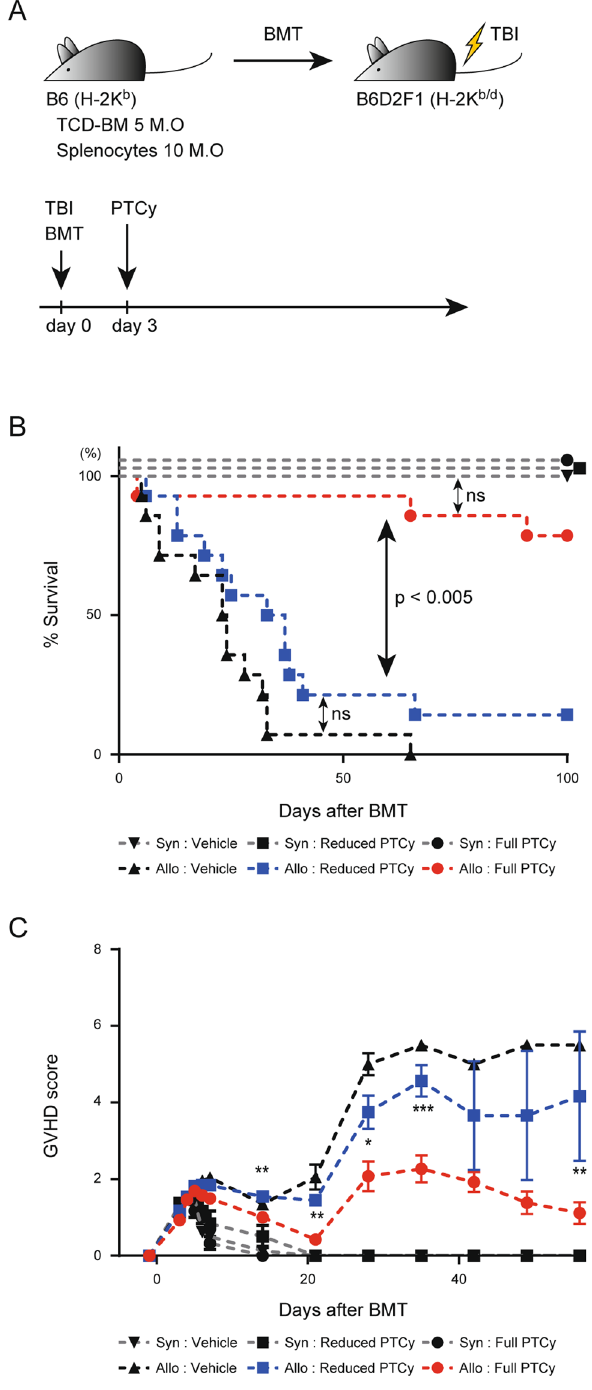
Figure 1. GVHD is prevented by optimized treatment with PTCy. ( A ) Experimental scheme: 5 × 10 6 TCD-BM cells and 10 × 10 6 splenocytes from B6 donor mice were administered to lethally irradiated (12 Gy TBI) B6D2F1 recipient mice. Cyclophosphamide or a control vehicle was administered on day 3 after BMT. ( B ) Overall survival rates of the vehicle (n = 14), reduced PTCy (n = 14) and full PTCy (n = 14) groups at serial time points. Data are representative of four independent experiments. P values were determined by the log-rank test and Holm’s adjustment for multiple comparisons. ns, not significant ( P > 0.05). ( C ) Clinical scores of the vehicle (n = 14), reduced PTCy (25 mg/kg) (n = 14) and full PTCy (50 mg/kg) (n = 14) groups at serial time points. Data are representative of four independent experiments and expressed as the mean ± SEM. P values were determined by one-way ANOVA and Tukey’s adjustment for multiple comparisons (allogeneic: reduced PTCy vs allogeneic: full PTCy). * P < 0.05; ** P < 0.01; **** P <